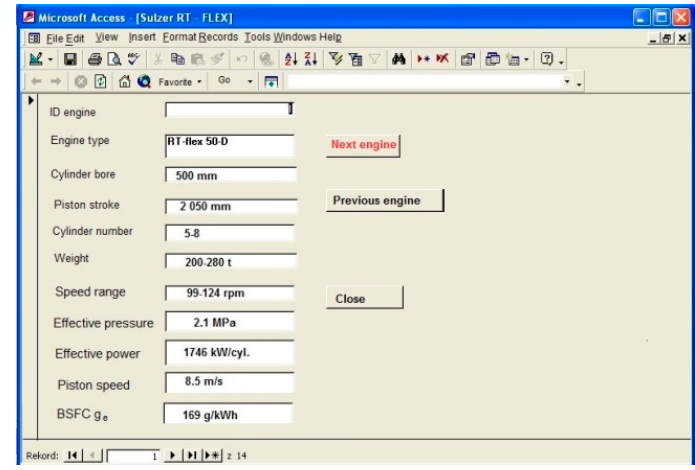
Figure 6. List of selected technical parameters of the example RT-flex engine.